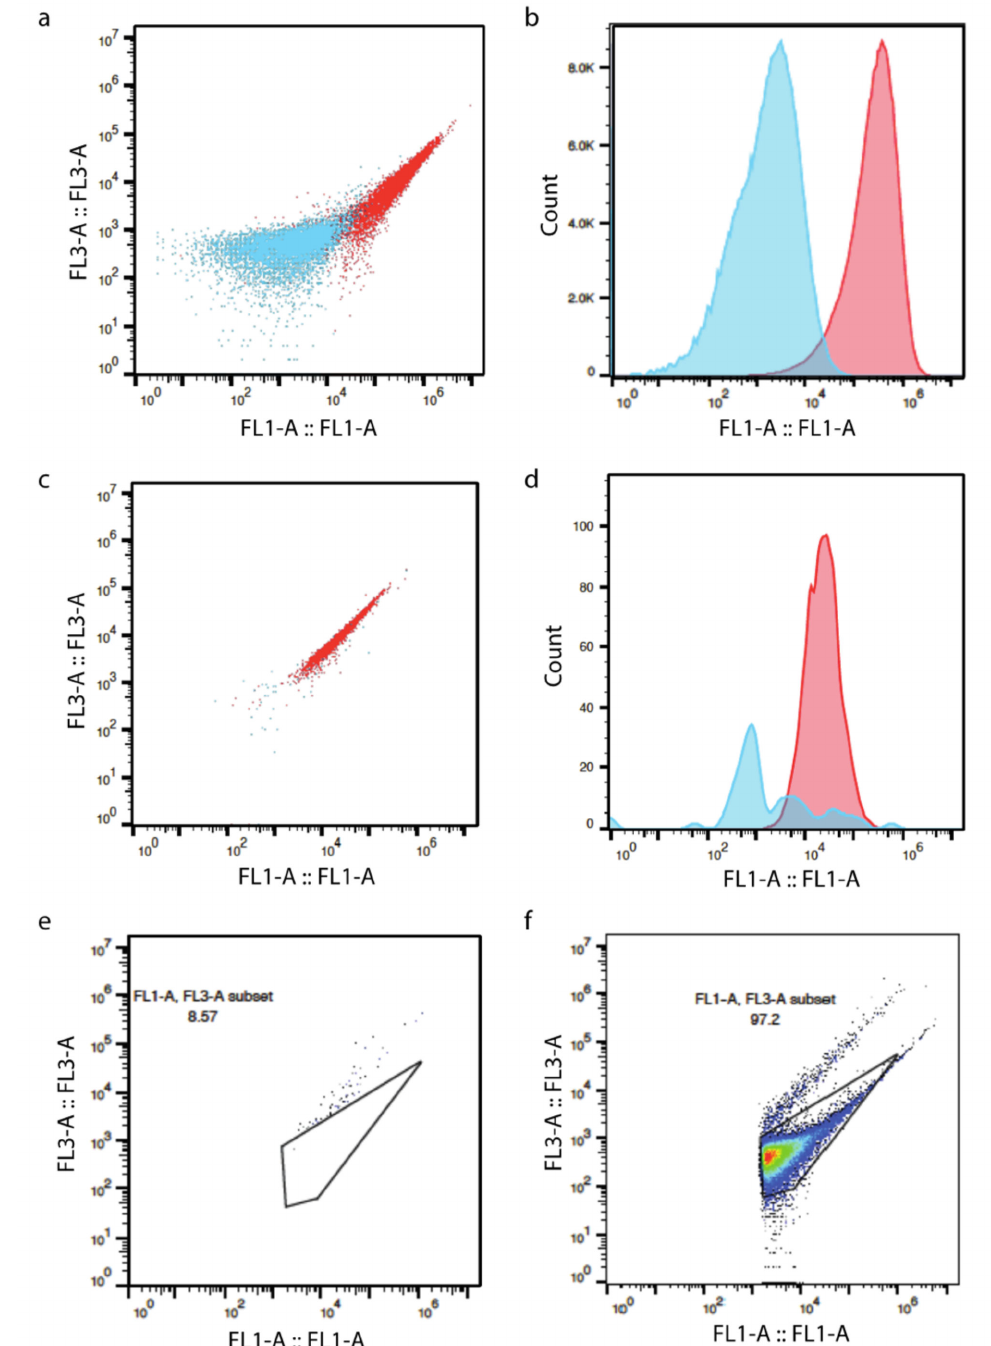
Figure 2. Flow cytometer plots of the same specimens (culture-enriched feces consortium with more background noise: ( a , b ); pure culture of E. coli : ( c , d )) with or without SYBR green staining (blue: non-stained; red stained). Flow cytometer plotting of buffer was used as gating guidance to exclude noises (negative control, ( e )). Gating strategy used for bovine respiratory microbial quantification ( f